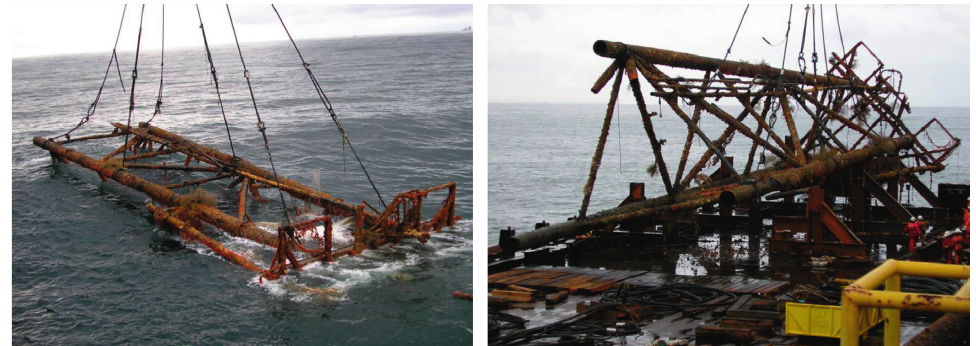
Figure 1: Baram-8 was rearranged into artificial reef structures